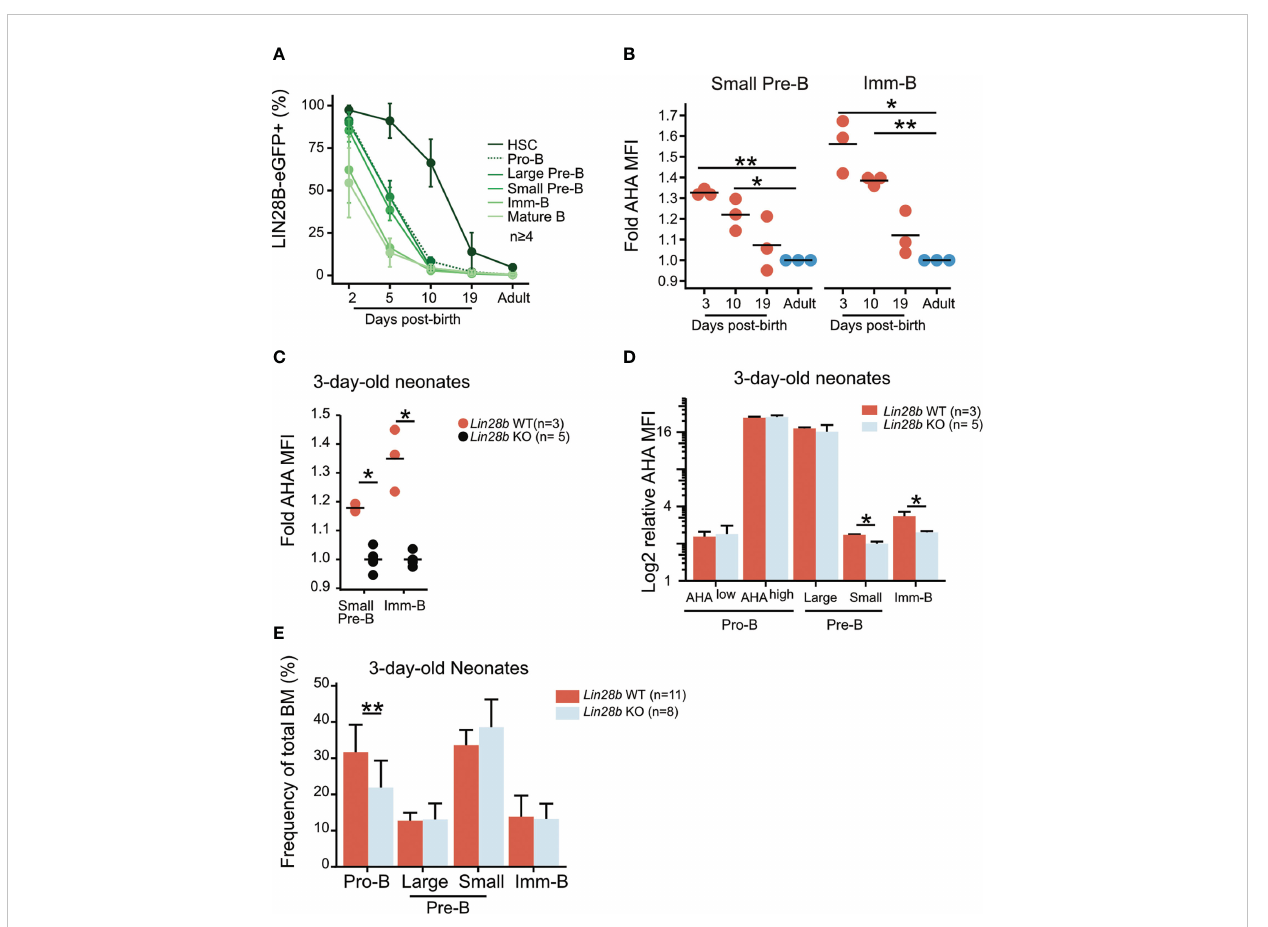
FIGURE 4 Elevated protein synthesis during neonatal B cell development is dependent on LIN28B. (A) Analysis of BM hematopoietic stem cells (HSCs: Lineage – , Sca1+, cKit+, CD150+, CD48 – , FLT3+) and B cell precursors from Lin28b -eGFP mice at the indicated ages. The average frequency and standard deviation of Lin28b -eGFP positive cells is shown for each time point. (B) AHA MFI from Lin28b -WT neonates at the indicated ages are plotted relative to the uptake in WT adult control mice for each subset. (C) AHA MFI in 3-day-old neonates of the indicated genotypes. Values are normalized within each experiment to one Lin28b KO neonate per cell type. (D) Same as in C but normalized to one Lin28b KO small Pre-B cell sample within each experiment. (E) Frequency of BM B cell precursors in 3-day-old neonates. T-test was used to calculate p-values in B, Wilcox test was used to calculate p-values in C-E. **p<0.001, *p<0.05. Bars show mean standard